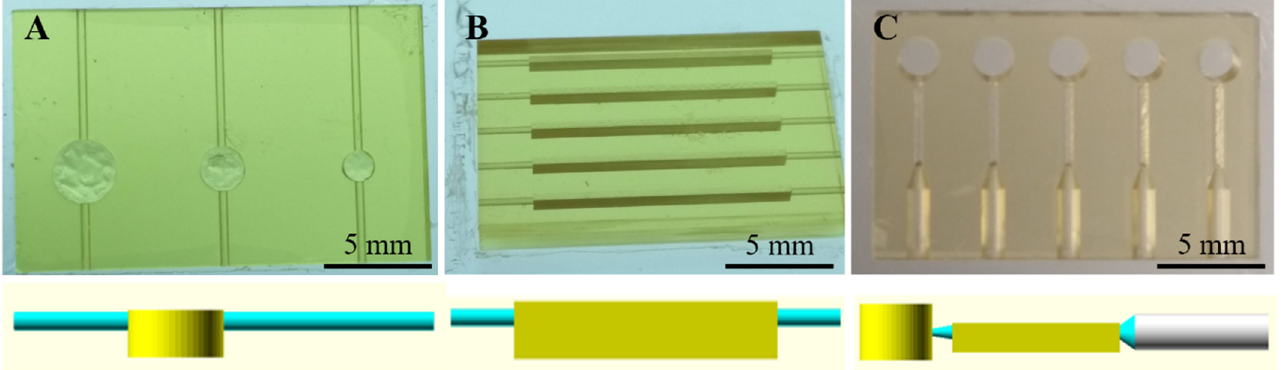
Figure 2. 3D ‐ printed devices (resin A) and the CAD design of the lateral view of the channels. Device 3 ( A ) consisted of round ‐ like chambers and three independent channels. Devices 4 ( B ) and 14 ( C ) consisted of rectangle ‐ like sedimentation trenches and five independent channels.